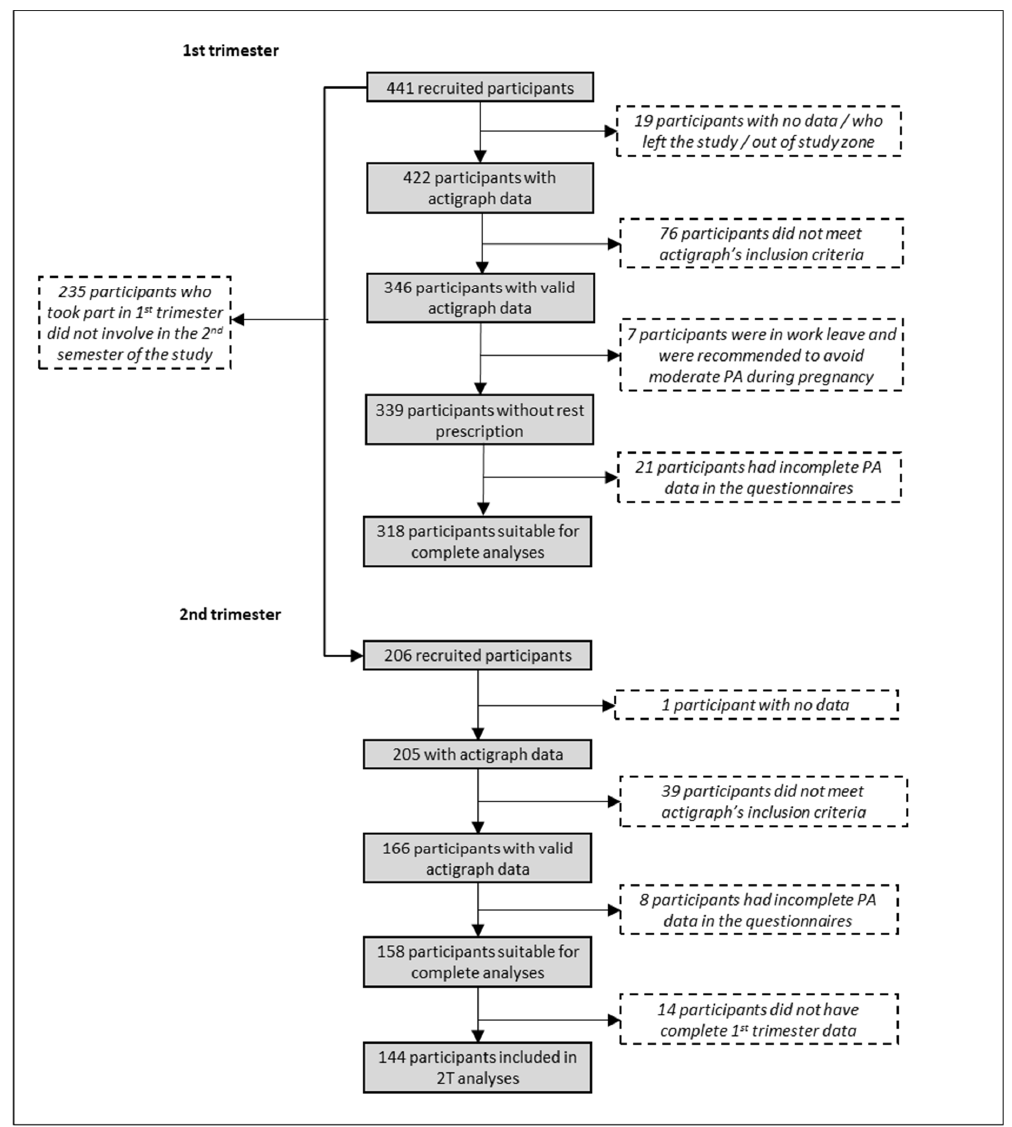
Figure 1. Flowchart showing participants included in the 1st and 2nd trimester analyses.